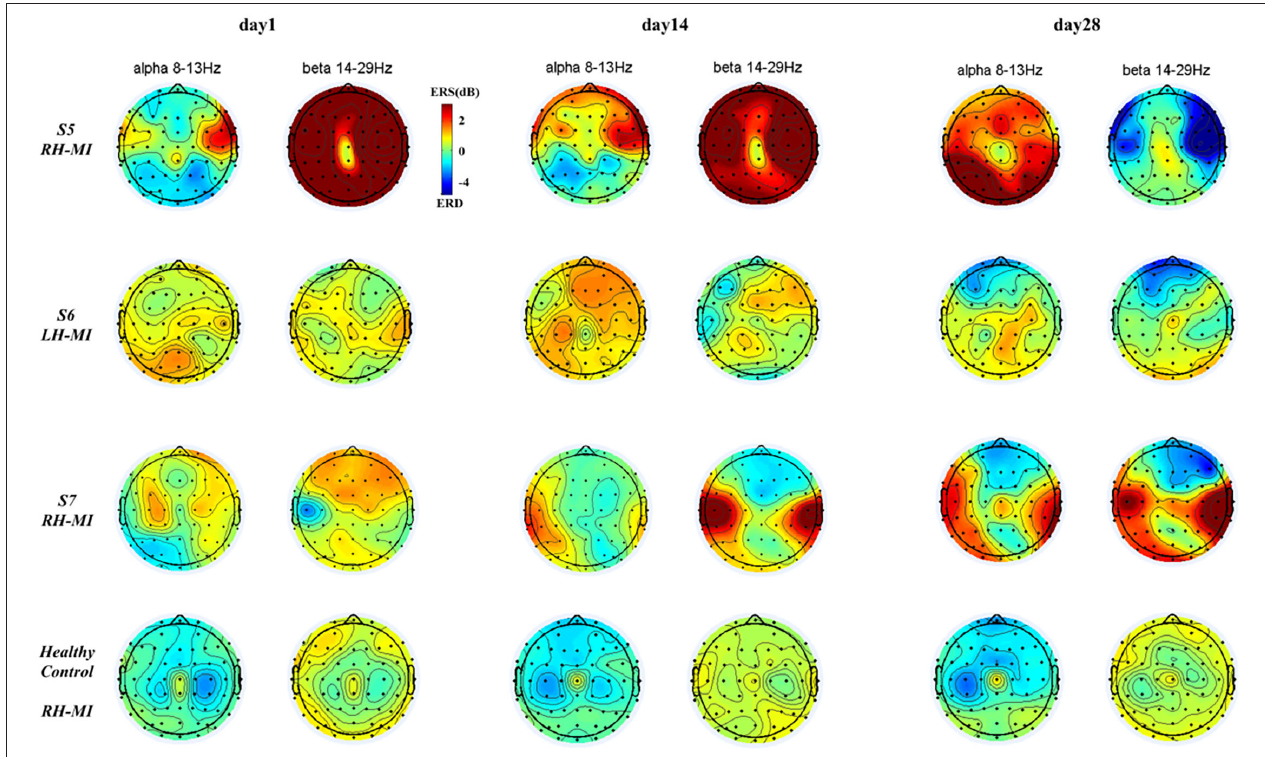
FIGURE 8 | The results of EEG brain topographic map under standard assessment session in long-term rehabilitation